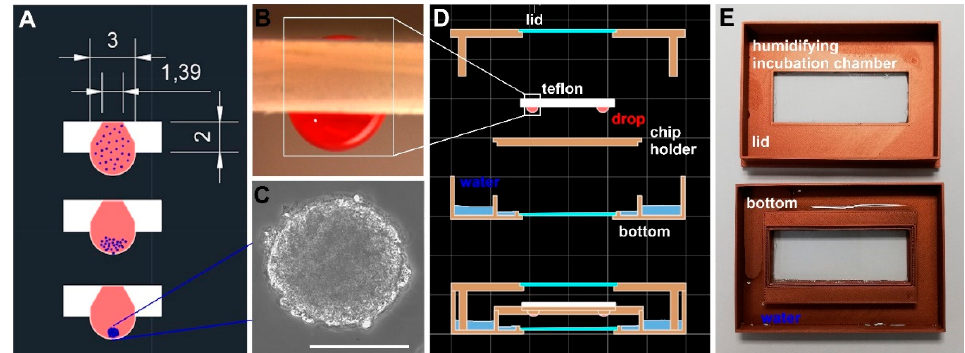
Figure 1. Devices supporting cell aggregation. ( A ): a schematic illustration/cross-section of the Teflon plate (white) utilized for the formation and incubation of hanging drops. Geometric measures of the drill hole and the plate thickness are given in mm. The process of cell aggregation (blue dots) within the cell culture media (red) is depicted as a sketch; ( B ) (side view): a picture of a hanging drop (for enhanced contrast, 20 µL of a deep red-colored solution was dispensed) held in place in the milled Teflon material; ( C ): a widefield microscopic image of stably aggregated osteoblasts forming a so called “spheroid” (the scale bar indicates 100 µm); ( D ): a schematic illustration of an incubation chamber including rectangular cutouts fitted with glass slides to allow for cell aggregation and observation. The chamber provides humidified atmospheric conditions, preventing the evaporation of the culture media during hanging drop formation at elevated cultivation temperatures; ( E ): the assembled incubation chamber.